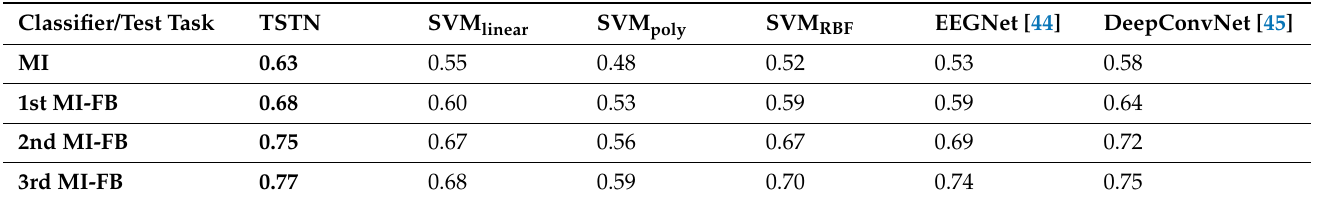
Table 3. The comparisons of the detected accuracies between TSTN and SVMs with different kernel